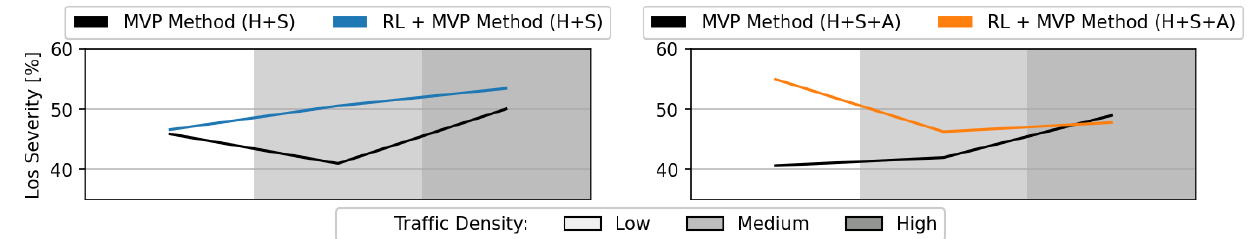
Figure 15. LoS severity during testing of the RL